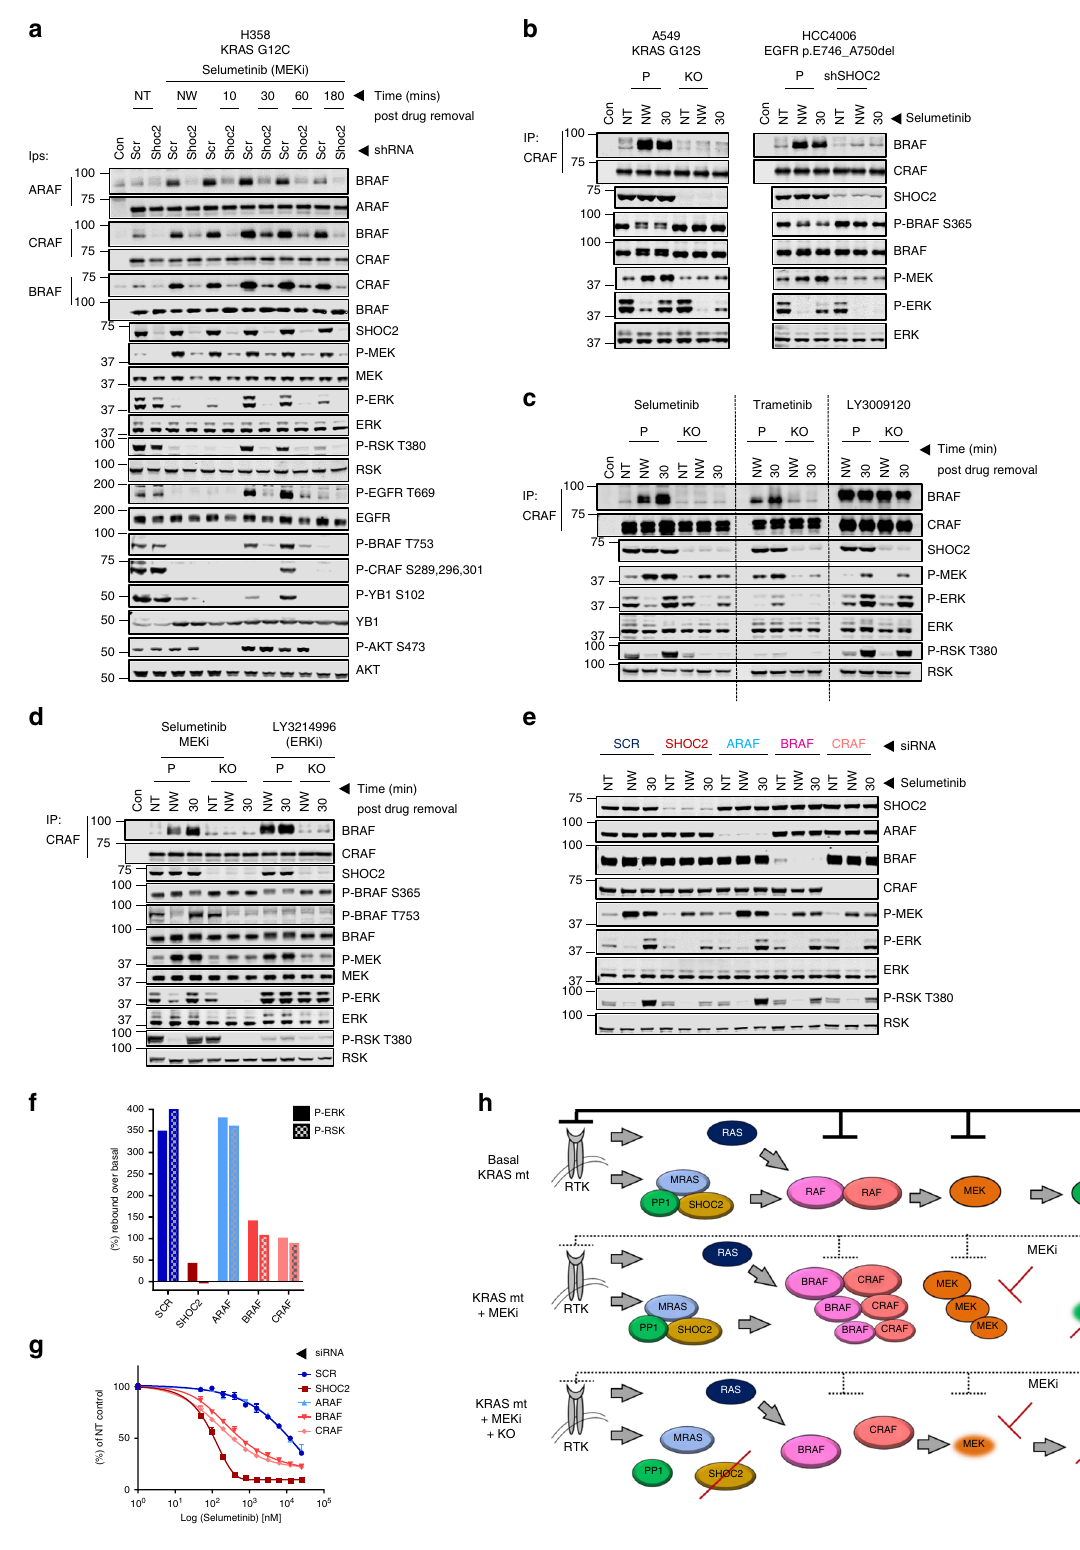
Methods Cell culture and generation of stable cell lines . HEK293 (UCL) and NSCLC cells obtained from the CRUK Central Cell Services facility (Francis Crick) were cul- tured in DMEM supplemented with 10% FBS at 37 °C under 5% CO 2 . NL20 cells, a gift from Charles Swanton ’ s research group were cultured in Ham ’ s F12 medium supplemented with 1.5g/L sodium bicarbonate, 2.7g/L glucose, 2.0 mM L-gluta- mine, 0.1 mM nonessential amino acids, 0.005 mg/ml insulin, 10ng/ml epidermal NATURE COMMUNICATIONS| (2019) 10:2532